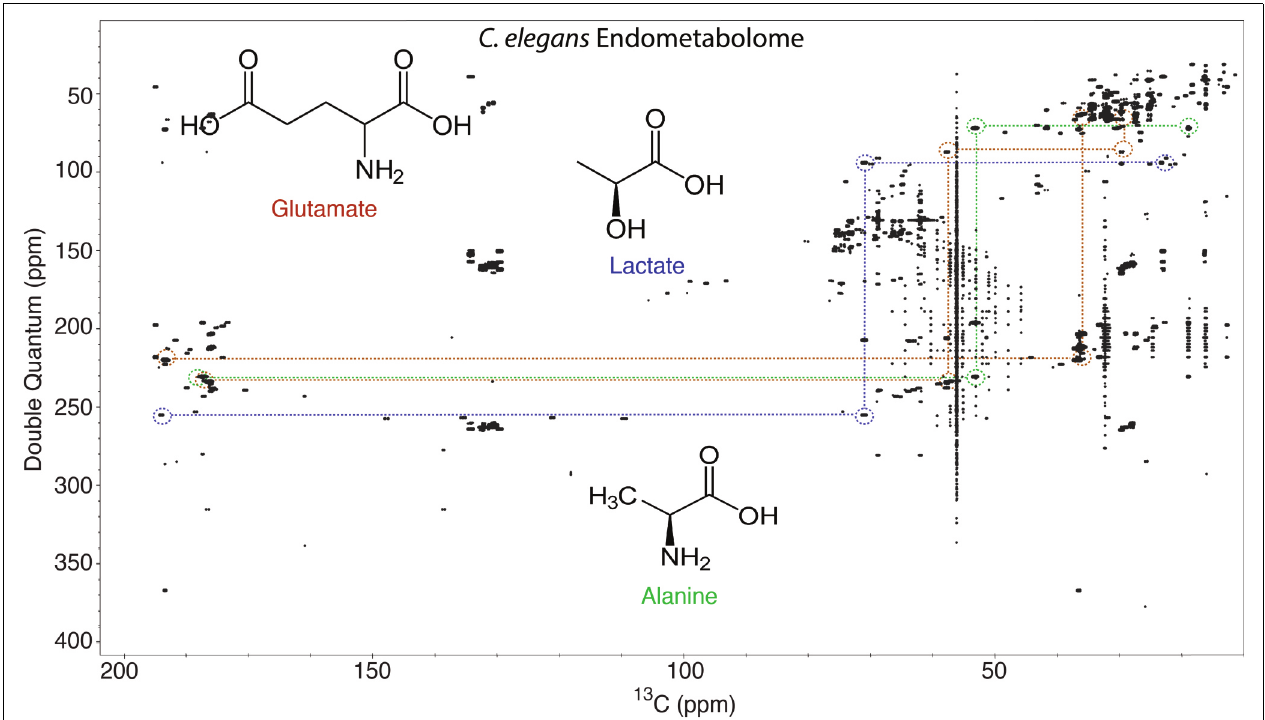
FIGURE 7 | 2D INADEQUATE NMR spectrum of the endometabolome of 13 C-labeled C. elegans . The horizontal axis is the 13 C chemical shift, and the vertical axis is the double quantum chemical shift. Cross-peaks appear on the double quantum axis at the sum of the two interacting 13 C frequencies. This spectrum has a very large amount of information, and we developed INETA to